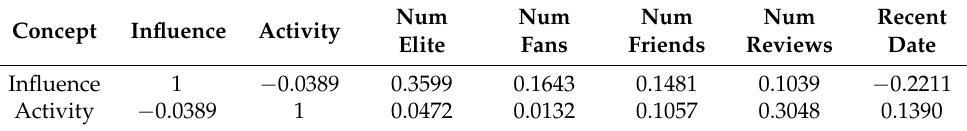
Table 5. Correlations between user influence, user activity, and the Yelp